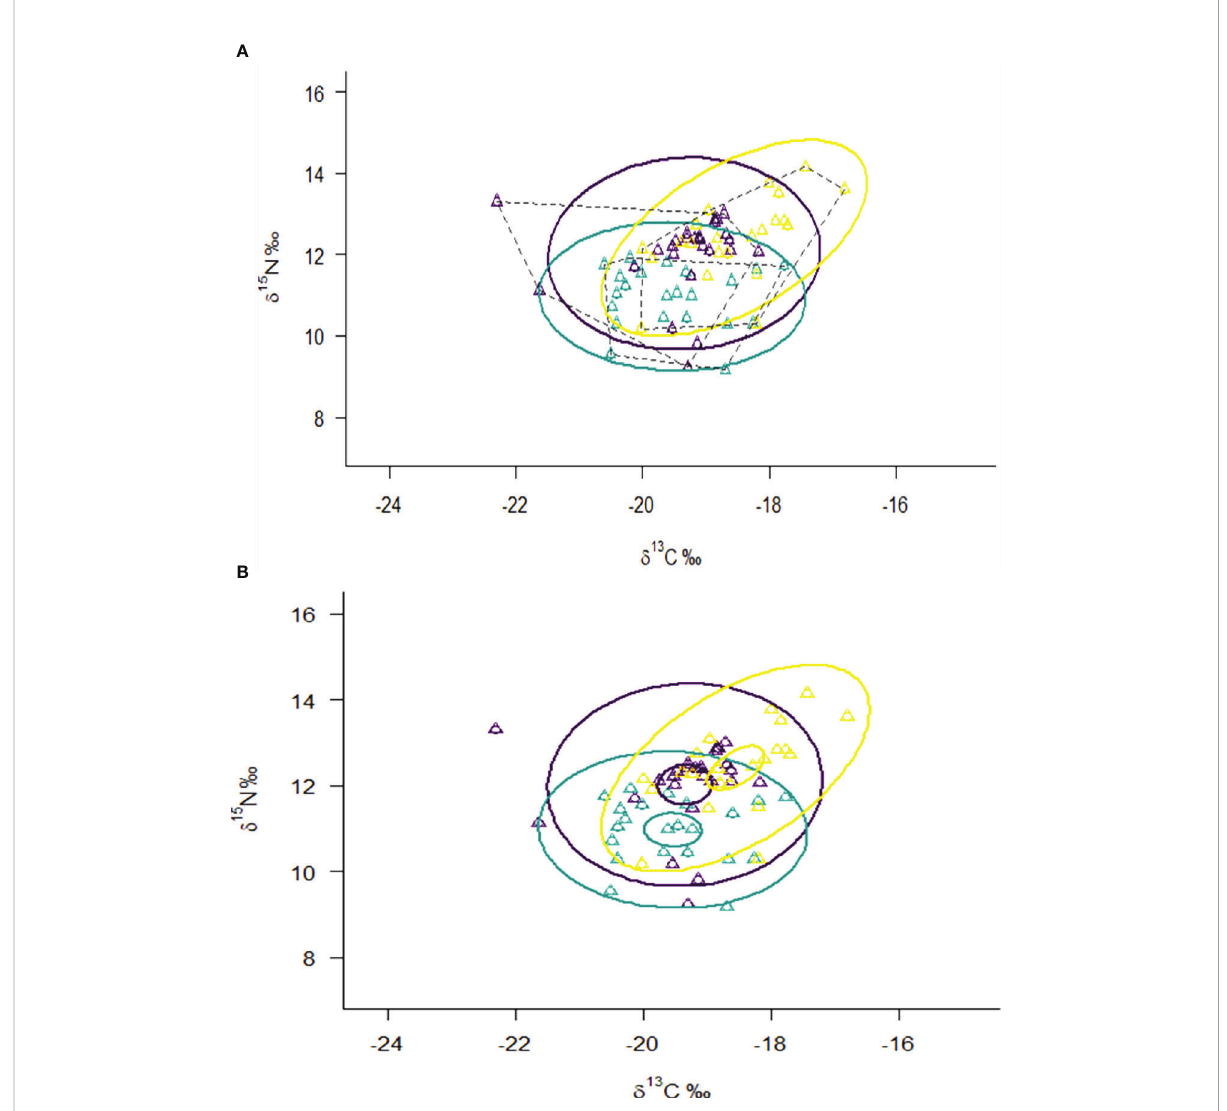
FIGURE 6 Isotopic niche width/overlap among different functional groups in the benthic ecosystem of the northern Yellow Sea. (Ellipse in (A) is the standard ellipses area (SEA), representing the isotopic niche of different functional groups; dotted lines are the total area (TA) of the convex hulls representing the total niche width. The small ellipse in (B) represents 95% con fi dence intervals for the means of d 13 C and d 15 N; purple represents M. senile ; yellow represents adult fi sh and cephalopod; The blue represents crustaceans and juvenile fi sh).